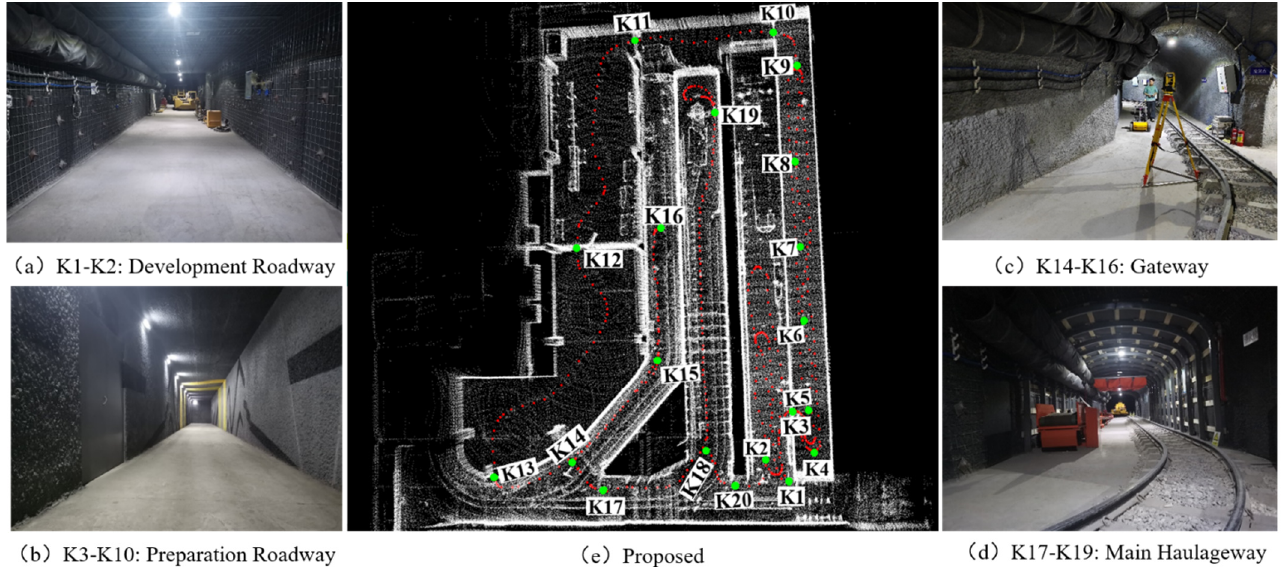
Figure 7. Data collection environment and the mapping result in the underground coal mine. ( a – d ) The corresponding data collection environment. ( e ) The mapping result by the proposed method and the layout of reference points.